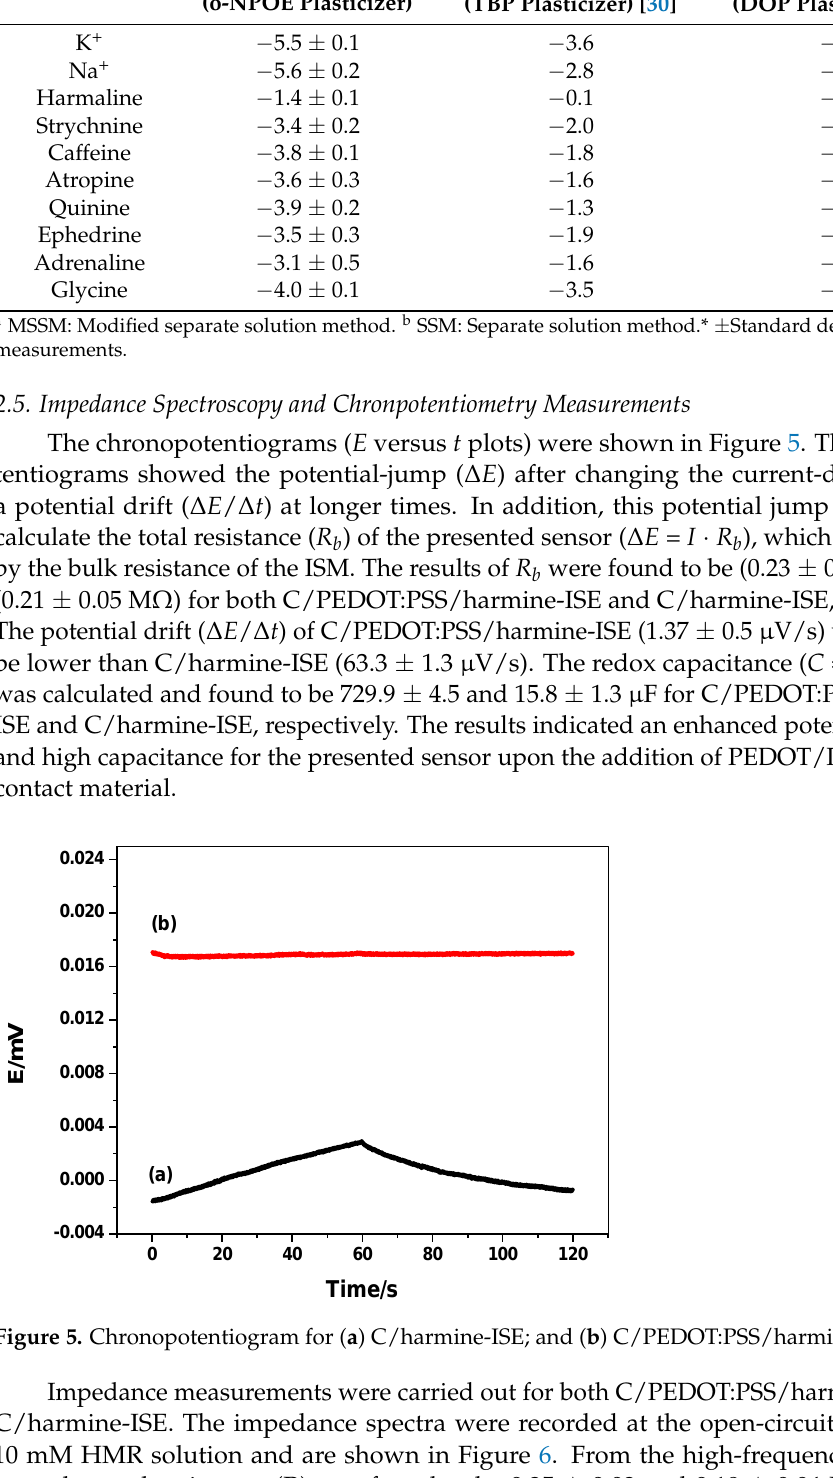
Figure 6. Impedance spectra for (a) C/harmine-ISE and (b) C/PEDOT:PSS/harmine-ISE. 2.6. Water-Layer Test A severe potential drift can arise in the ISE because of the existence of the water-layer between the ISM and the electronic substrate. This potential drift can be eliminated after the insertion of a hydrophobic solid-contact layer at the interface between the ISM and the